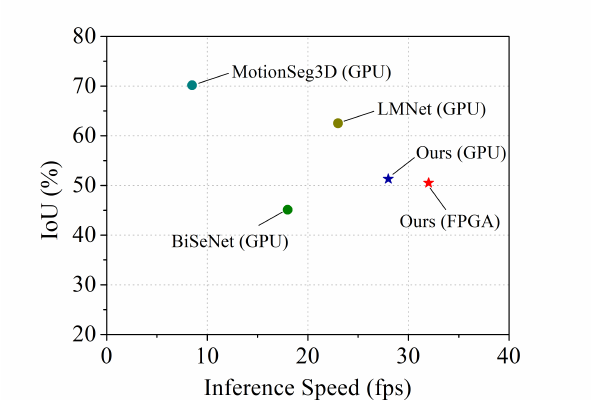
Figure 6. Inference speed vs. IoU on the SemanticKITTI validation set. Red star indicates our method in FPGA, the blue star indicates our method in GPU, and colored dots represent other methods.